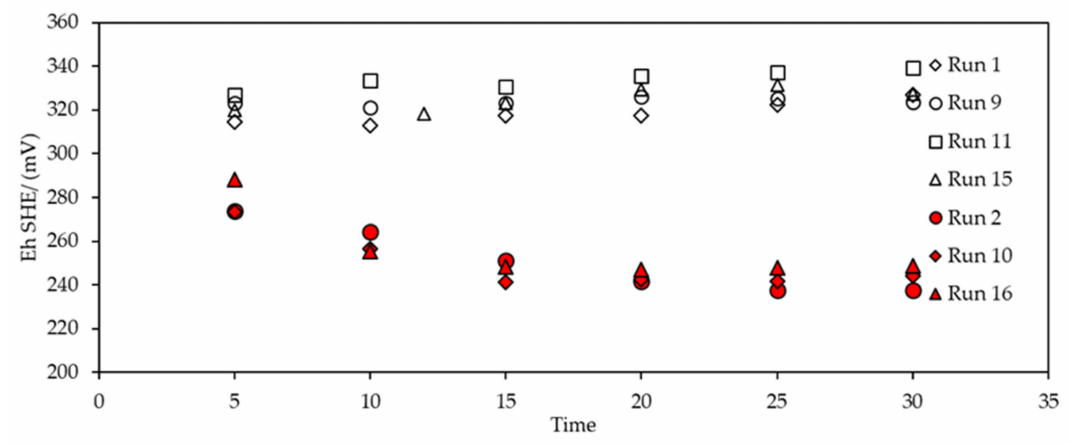
Figure 3. Plot of Eh vs time for various conditions of collector adsorption on chalcopyrite. No Fill (5 ◦ C); Fill (65 ◦